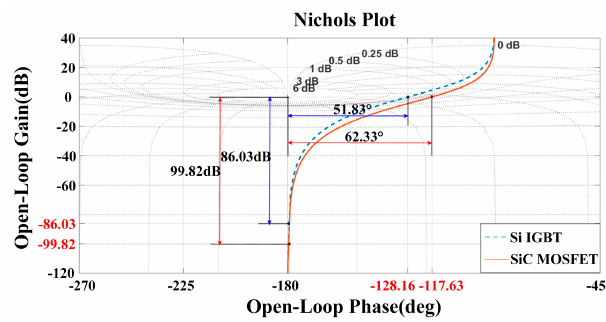
Figure 13. The Nichols plot of systems at 15 kHz switching frequency and 2 μ s dead time.